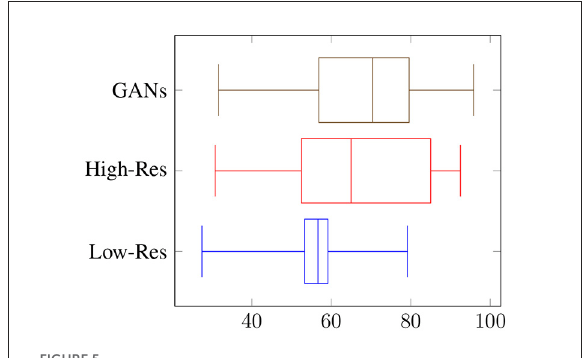
FIGURE5 Visual assessment of generated datasets: real/fake classification accuracy (%).